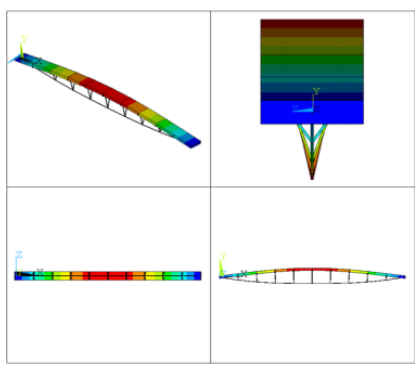
Processes 2022 , 10 , x FOR PEER REVIEW Figure 5. Symmetrical mode of vertical bending ( Figure 5. Symmetrical mode of vertical bending ( f s b = 1.65).